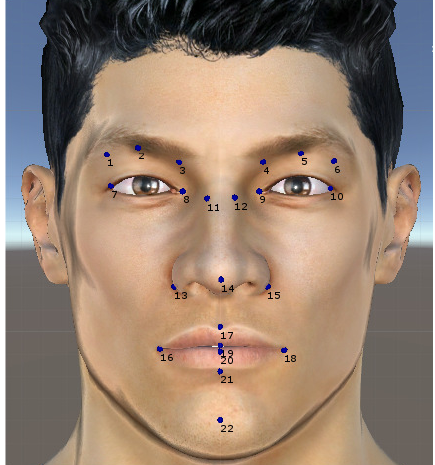
Figure 3. Twenty-two landmarks adapted in the UIBVFED